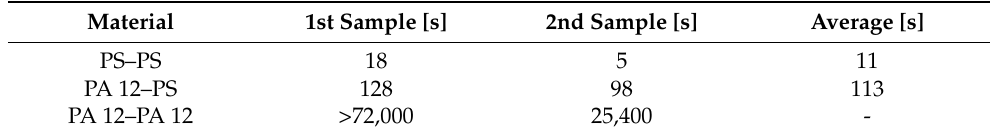
Figure 5. Adhesive strengths were measured with a LUMifrac device for three different material combinations of bonded substrates. PS–PS represents two PS specimens, PA–PS represents a combination of one PS and one PA 12 specimen, and PA–PA represents two PA 12 specimens. Each experiment was performed on four treated samples. The error bars indicate the standard deviation. Table 1. Detachment time of three different material combinations of joint materials. PS–PS represents two PS specimens, PA 12–PS is a combination of one PS and one PA specimen, and PA 12–PA 12 is two PA 12 specimens. Each experiment was performed on two samples.